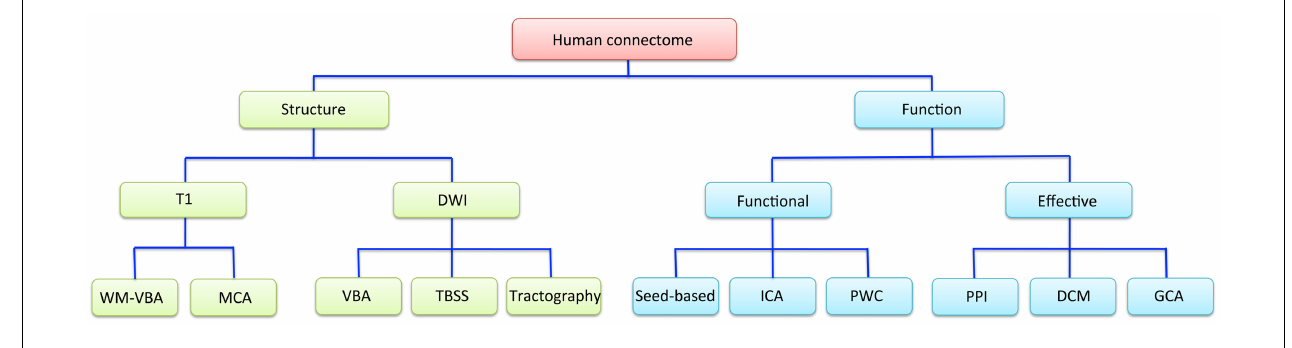
independent component analysis; MCA, morphometric covariance analysis; PPI, psychophysiological interactions; PWC, pair-wise correlations;TBSS, tract-based spatial statistics;T1,T1-weighted imaging;VBA, voxel-based analysis;WM, white